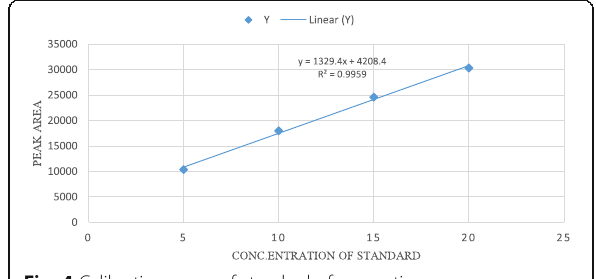
Fig. 4 Calibration curve of standard of quercetin